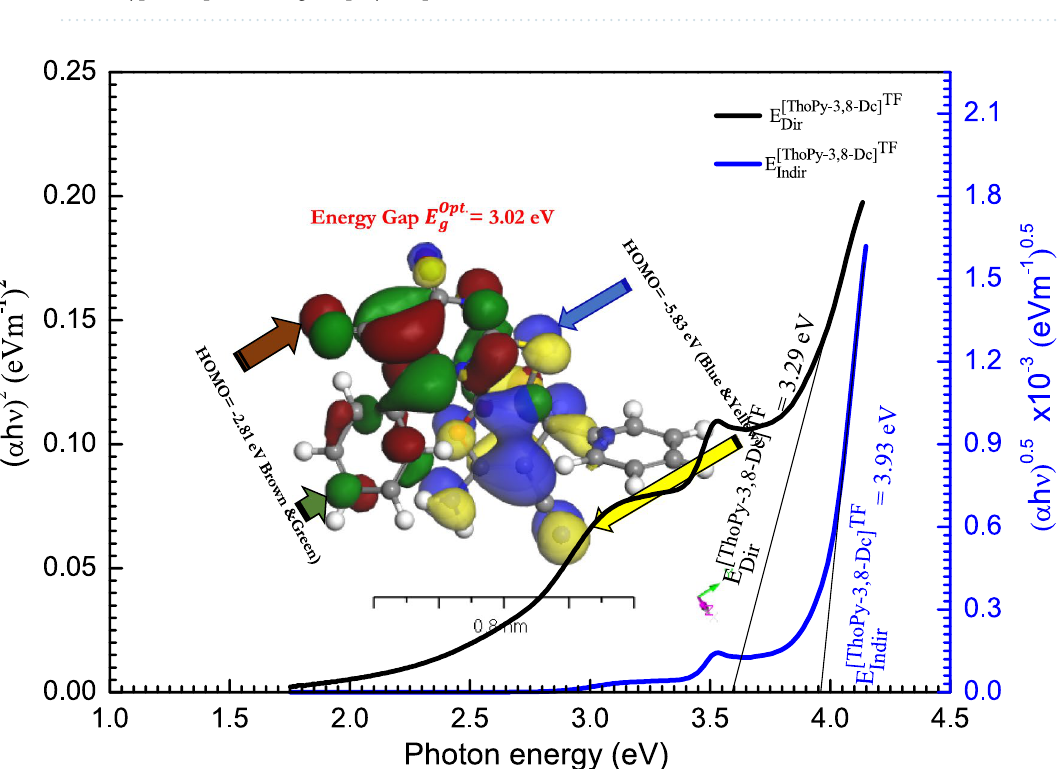
Figure 8. The relationship of photon energy with direct and indirect electronic transitions for [ThiPy-3,8- Dc] TF . The inset figure is a schematic diagram of theoretical calculations of the energy gap using TD-DFT/ DMol 3 method for the isolated